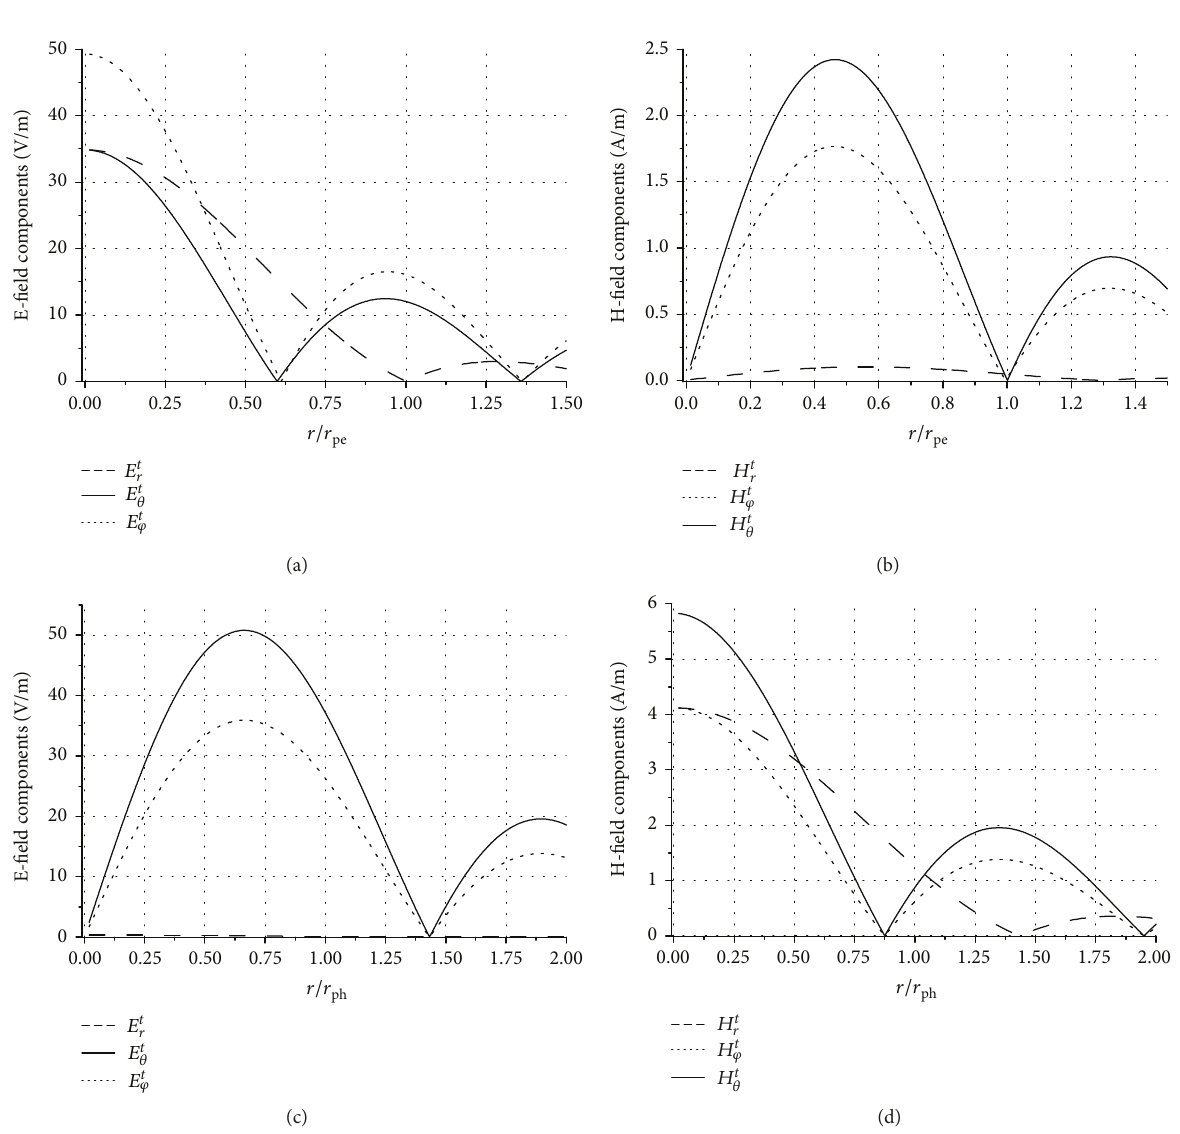
Figure 3: Field components distribution inside the particles for E (c) and (d) TE mode inside particles of radius r ph 011